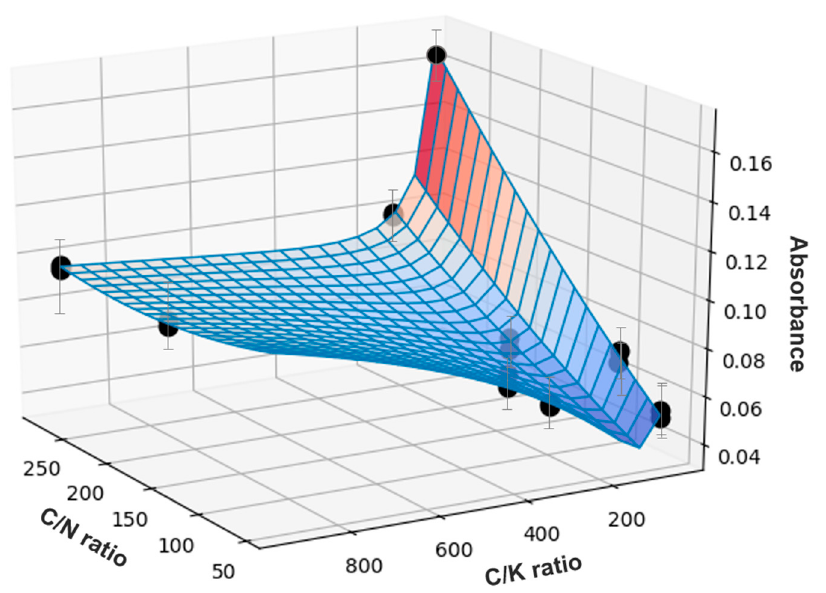
Figure 5. Response surface of the mathematical model of absorbance as a function of the C/N and C/K ratio, frontal view.